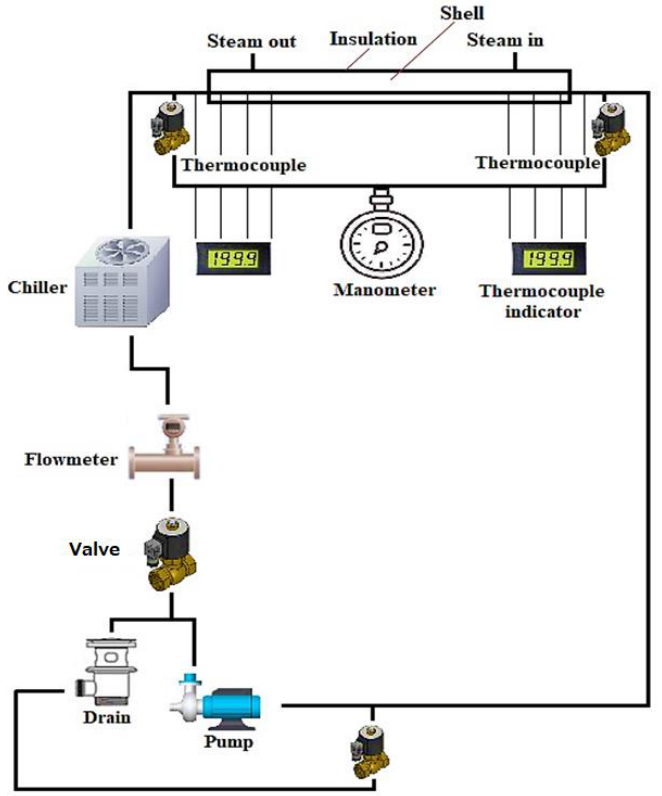
Figure 4. Schematic of experimental circuit.